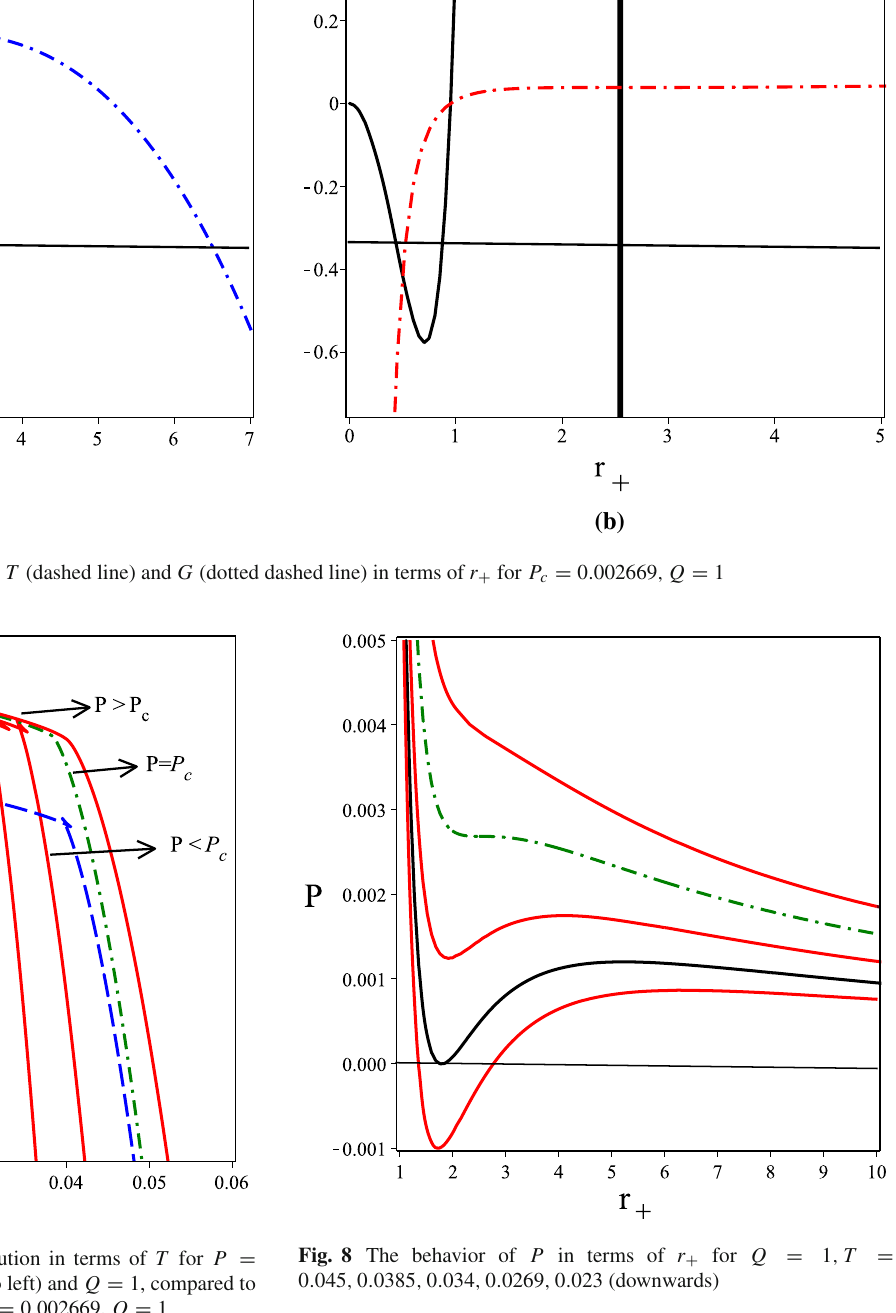
= 0 and ∂ 2 P = 0. By ∂ r 2 + r + = ( 0 . 002669 )( 2 . 54 ) = 0 . 176 T c 0 . 0385